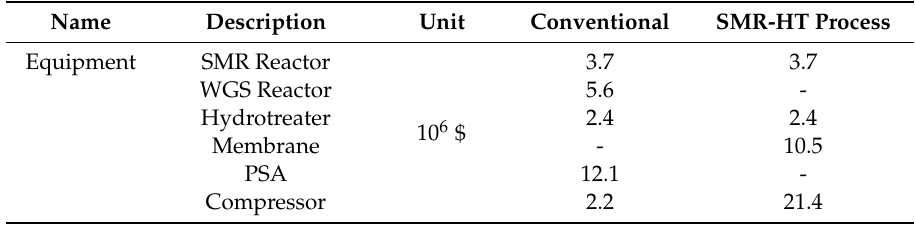
Table 6. Economic